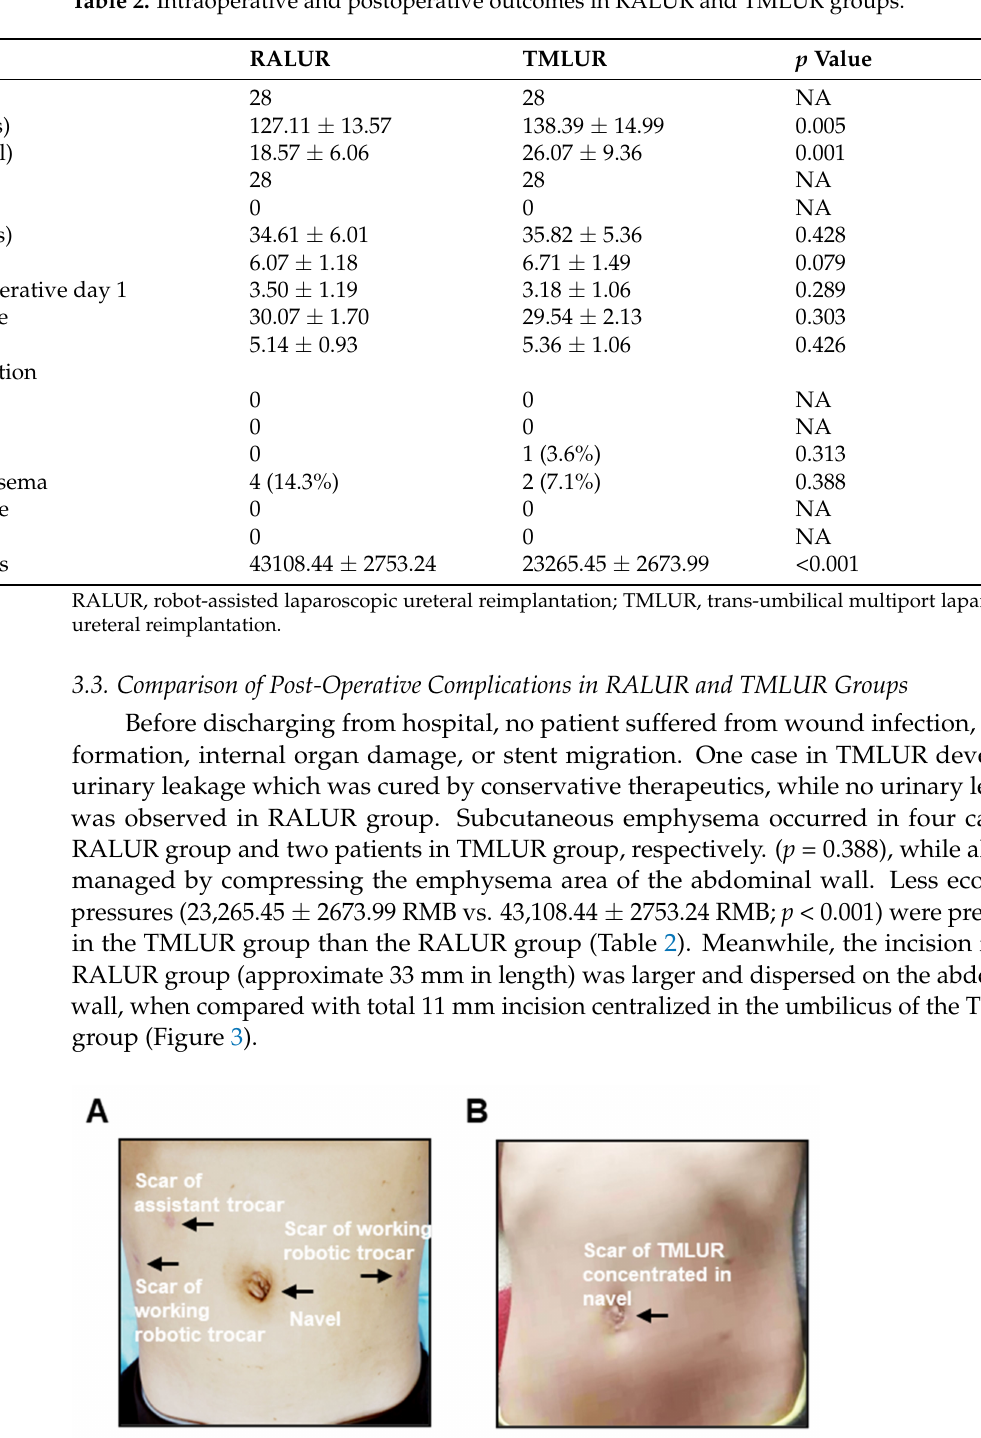
Table 2. Intraoperative and postoperative outcomes in RALUR and TMLUR groups.